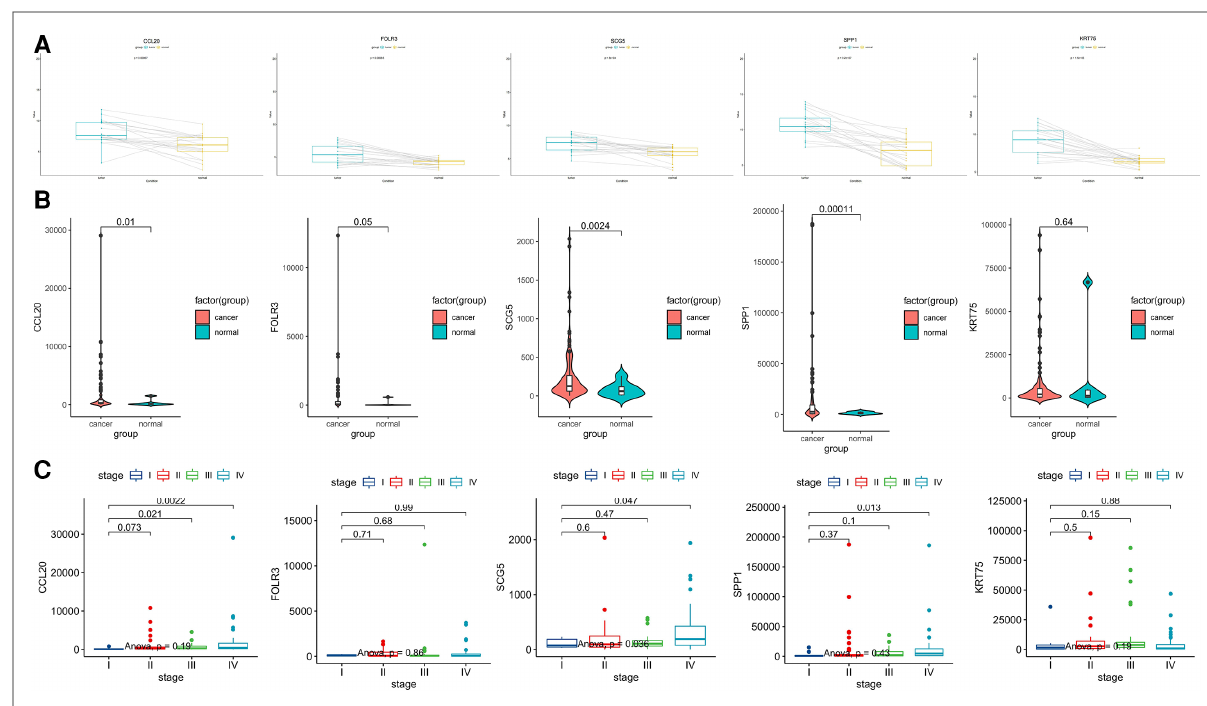
FIGURE 5 Further expression veri fi cation of these fi ve common upregulated genes ( CCL20 , SCG5 , SPP1 , FOLR3 , and KRT75 ). ( A ) Box plots showing the expression levels of these fi ve genes in tumor tissue compared with matched Normal tissue in the GSE13601 database, with lines connected to a pair of paired samples. ( B ) Violin diagram showing the comparison of the expression levels of these fi ve genes in TCGA tongue cancer tissue and Normal tissue. ( C ) Box diagram showing the expression of these fi ve genes at various stages in the TCGA